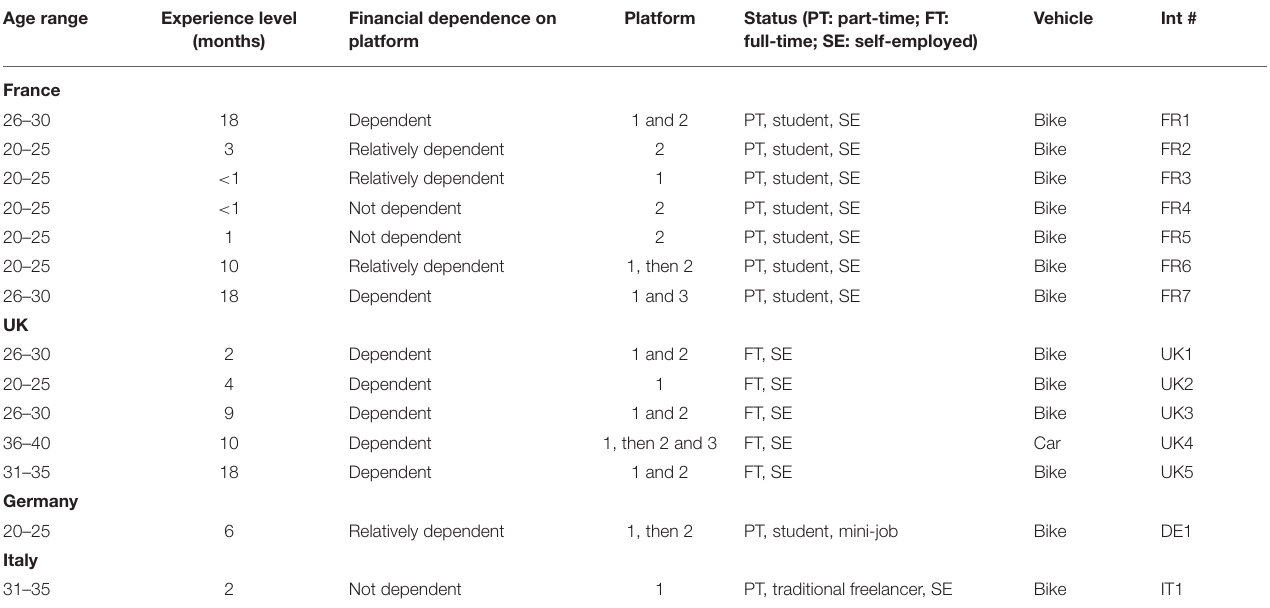
TABLE 1 | Participant